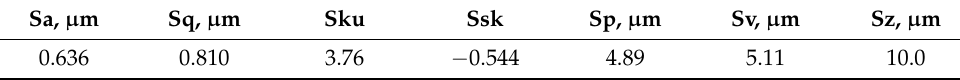
Figure 7. ( a ) Shape and dimensions of the countersamples (units in mm) and ( b ) topography of the countersamples. countersamples. Table 4. Basic surface roughness parameters of Table 4. Basic surface roughness parameters of countersamples.